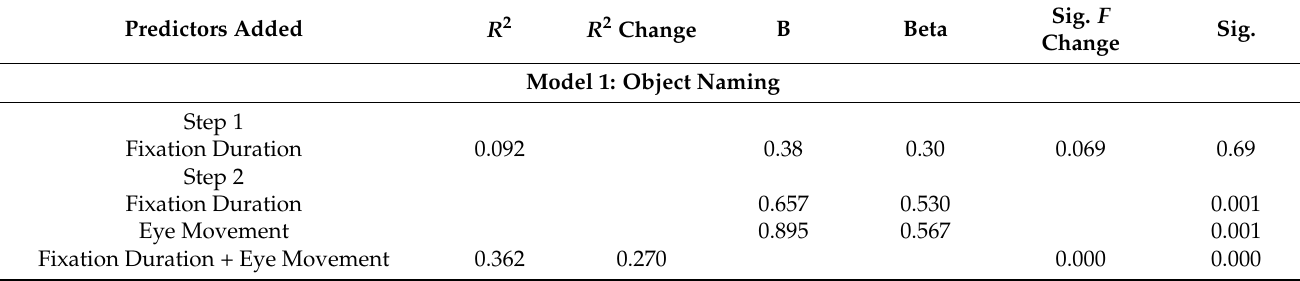
Table 12. Multiple hierarchical regressions for selected eye movement variables in Rapid Automatized Naming and total reading time in